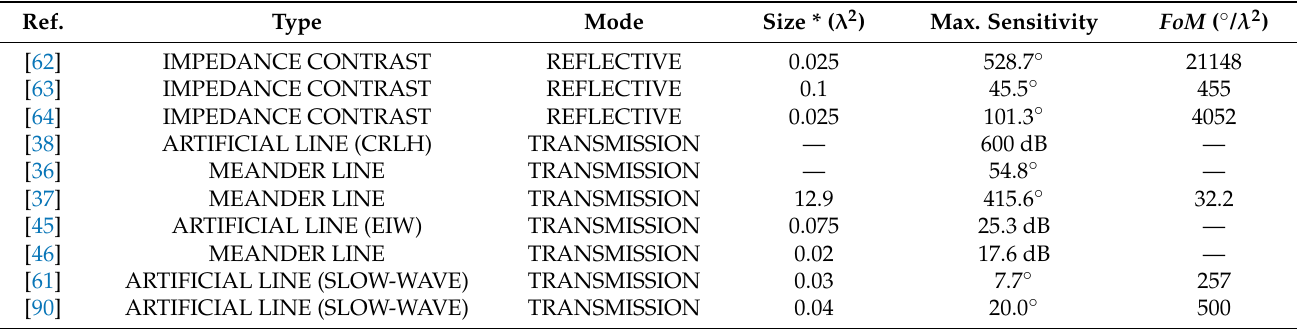
Table 1. Comparison of various phase